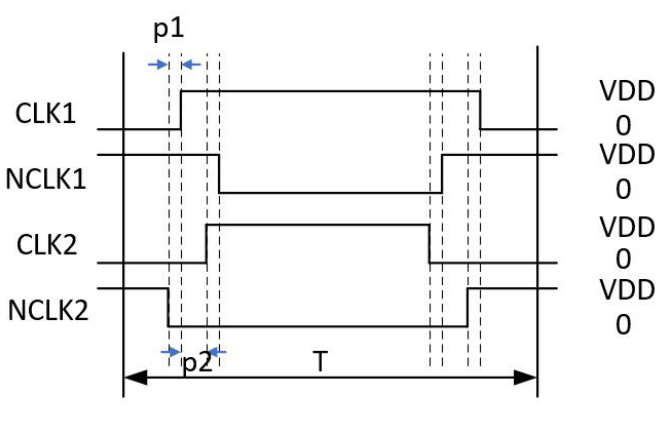
Figure 7. Timing diagram of four phase non-overlapping clocks.